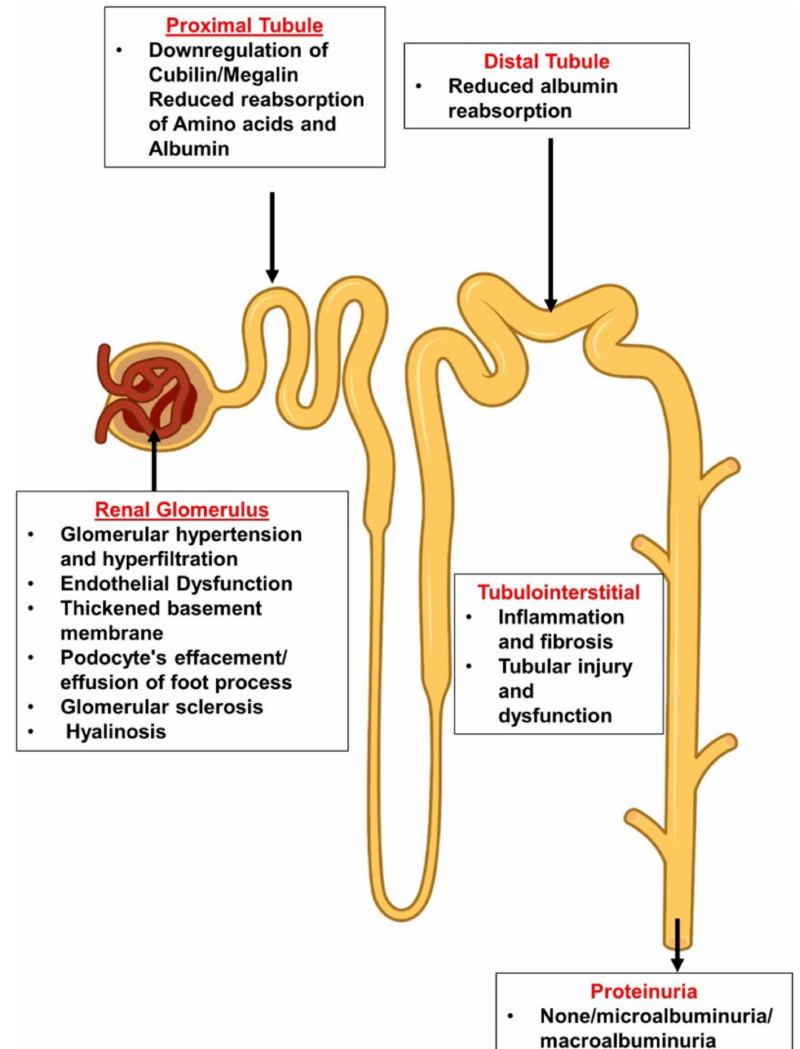
Figure 2. Glomerular and tubular deleterious alterations in the diabetic